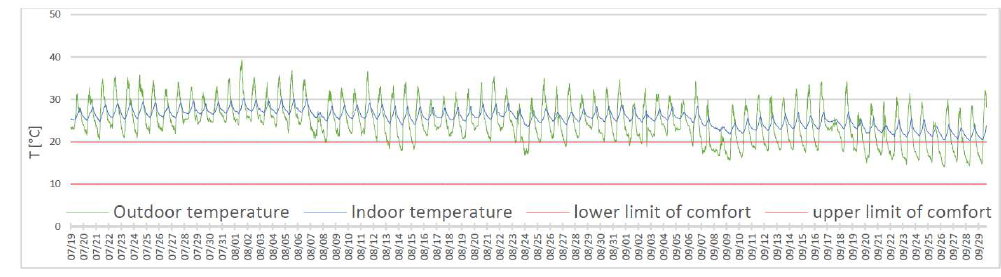
Figure 7. Outdoor and indoor temperature measured.